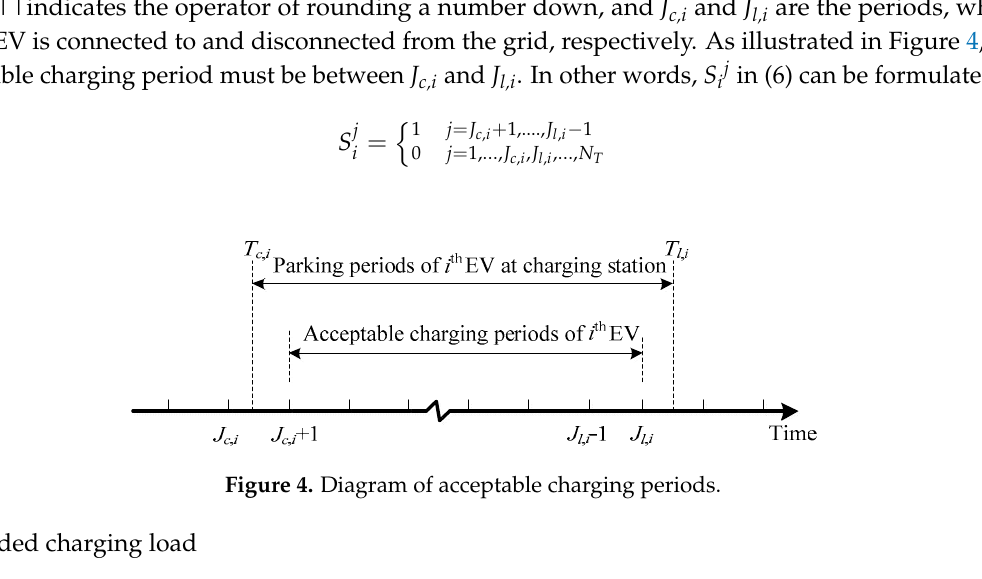
Figure 5. Decentralized control architecture.